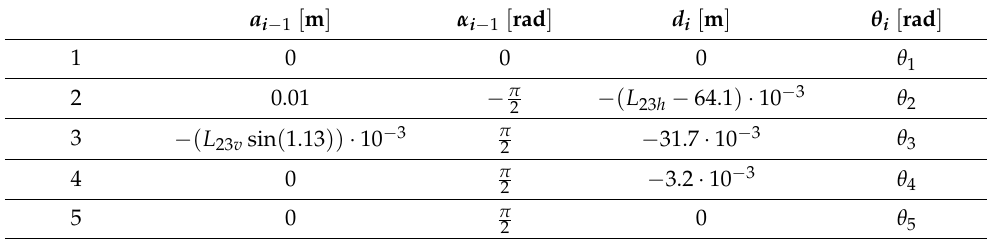
Table 2. Float mDH parameters.